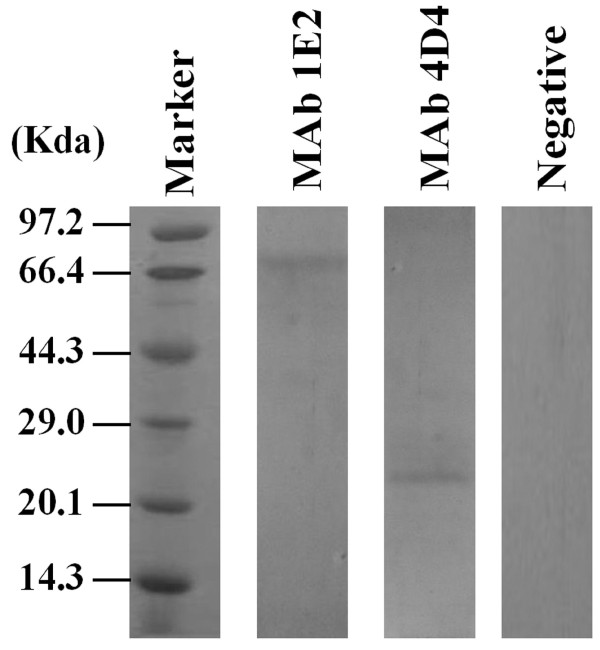
The MAb against PHE-CoV were identified by Western blot analysis. Lane 1: Prestained Protein Marke (TaKaRA, code: 530A, Dalian, P. R. China,) Lane 2: The purities of MAb 1E2 were used in Western blot analysis, which recognizes the S Protein of PHE-CoV. Lane 3: The purities of MAb 4D4 were used in Western blot analysis, which recognizes the HE Protein of PHE-CoV. Lane 4: The SP2/0 cells was injected into Balb/C nude mice and the mouse abdominal dropsy, and the purities were used negative control.